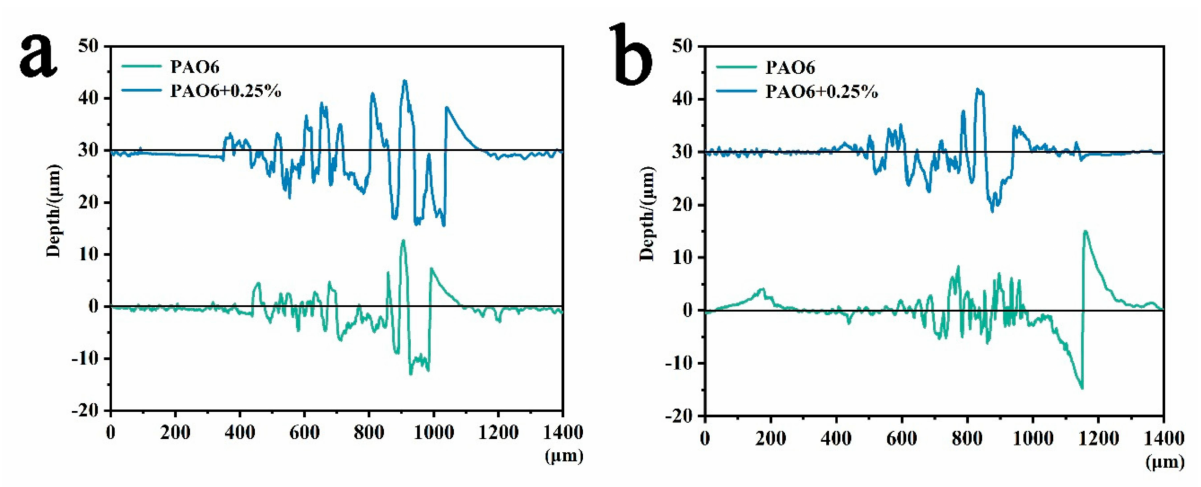
Figure 6. 2D and 3D morphologies of wear surfaces of pure PAO6 and 0.25 wt% IF–WS 2 /PAO6 at 75 °C ( a , b ) and 100 °C ( c , d ).